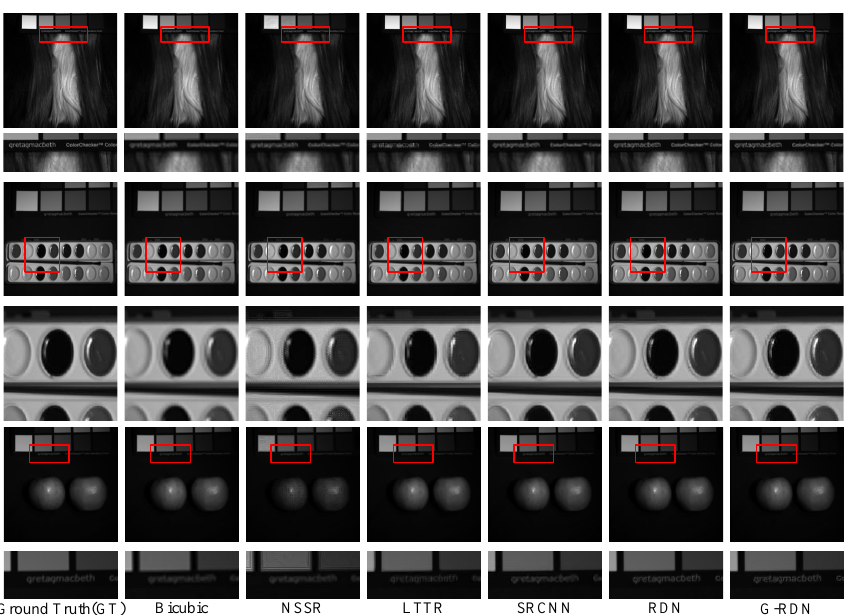
Figure 6. Visual exhibition of the reconstructed test HSIs for the CAVE dataset at the scaling factor of 3.